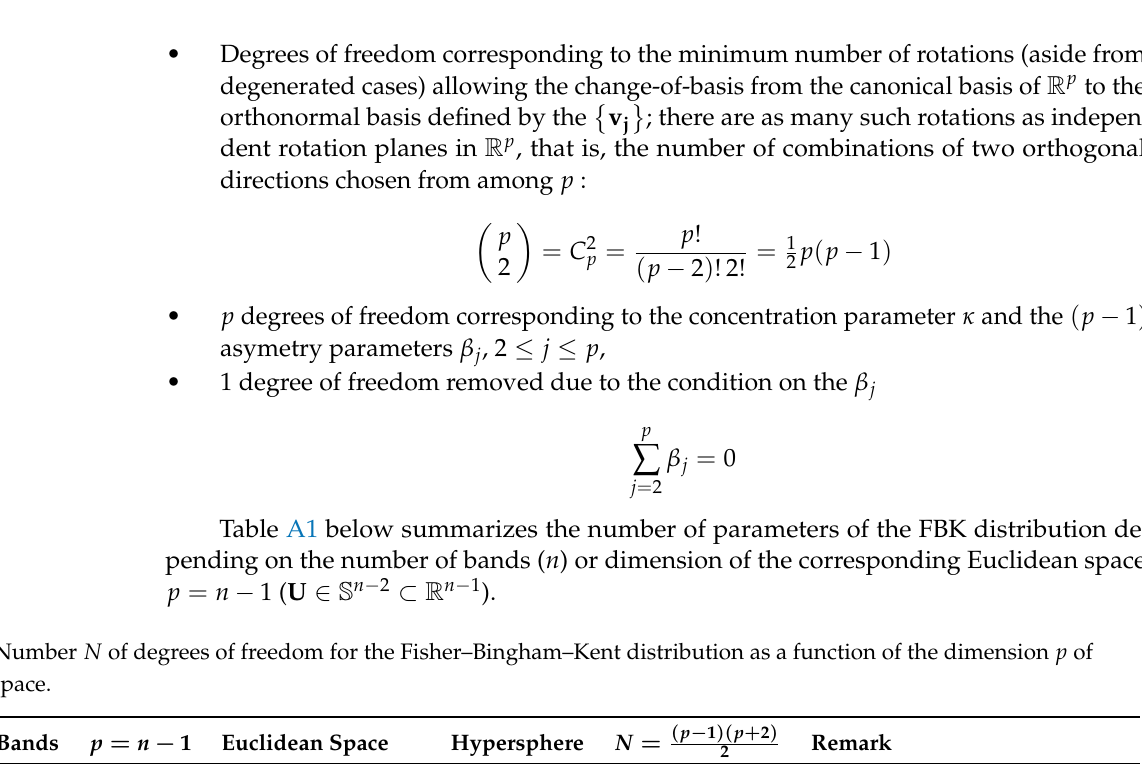
Table A1. Number N of degrees of freedom for the Fisher–Bingham–Kent distribution as a function of the dimension p of the initial